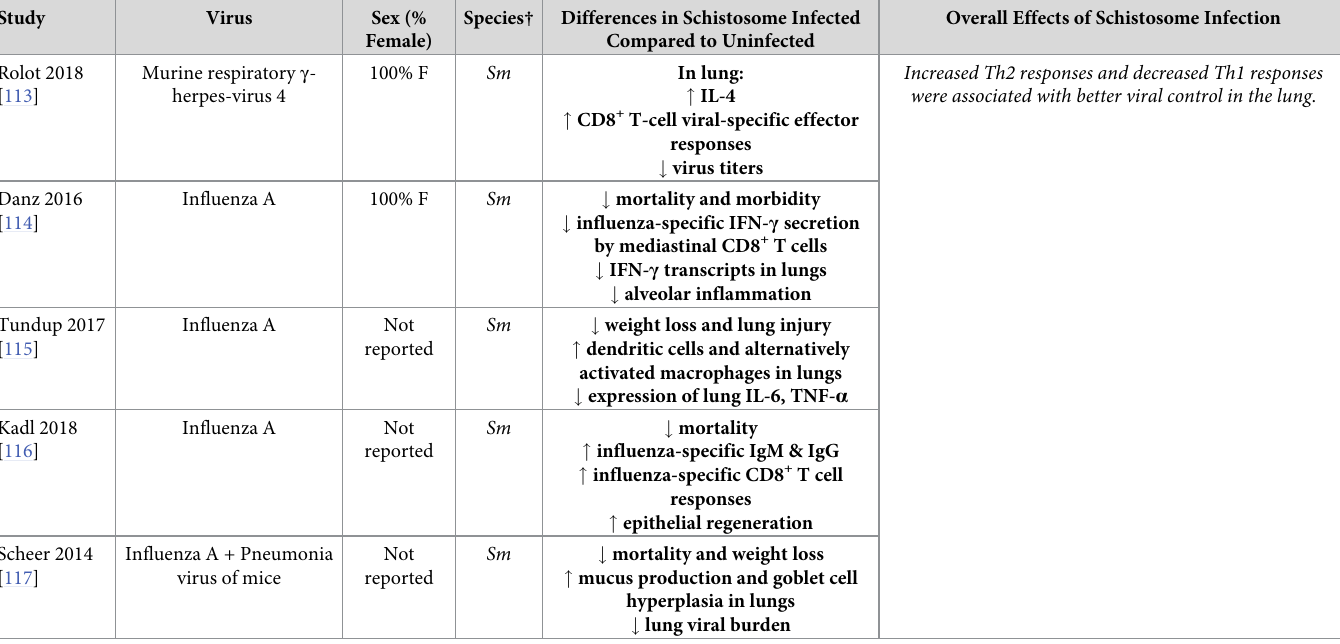
Table 8. Effects of Schistosome Infection on the Host Immune Response to Respiratory Viruses in Mice.